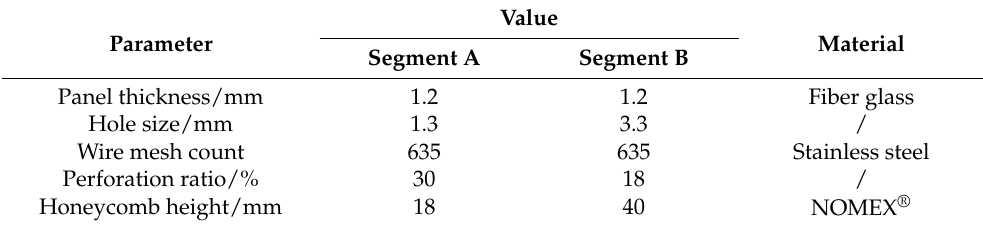
Figure 13. Acoustic directivity of (15, 0) circumferential mode at 1250 Hz.